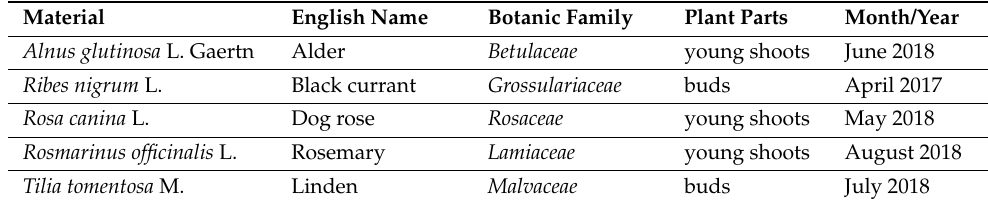
Table 5. List of analyzed samples.